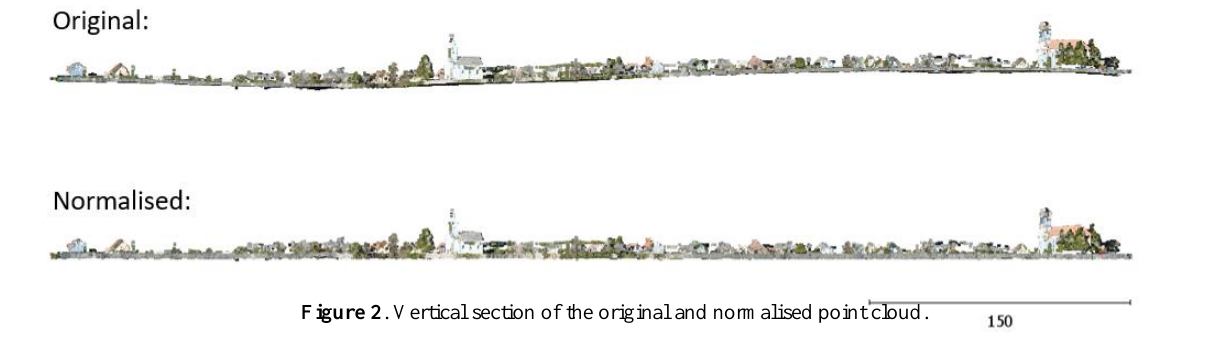
Figure 2 . Vertical section of the original and normalised point